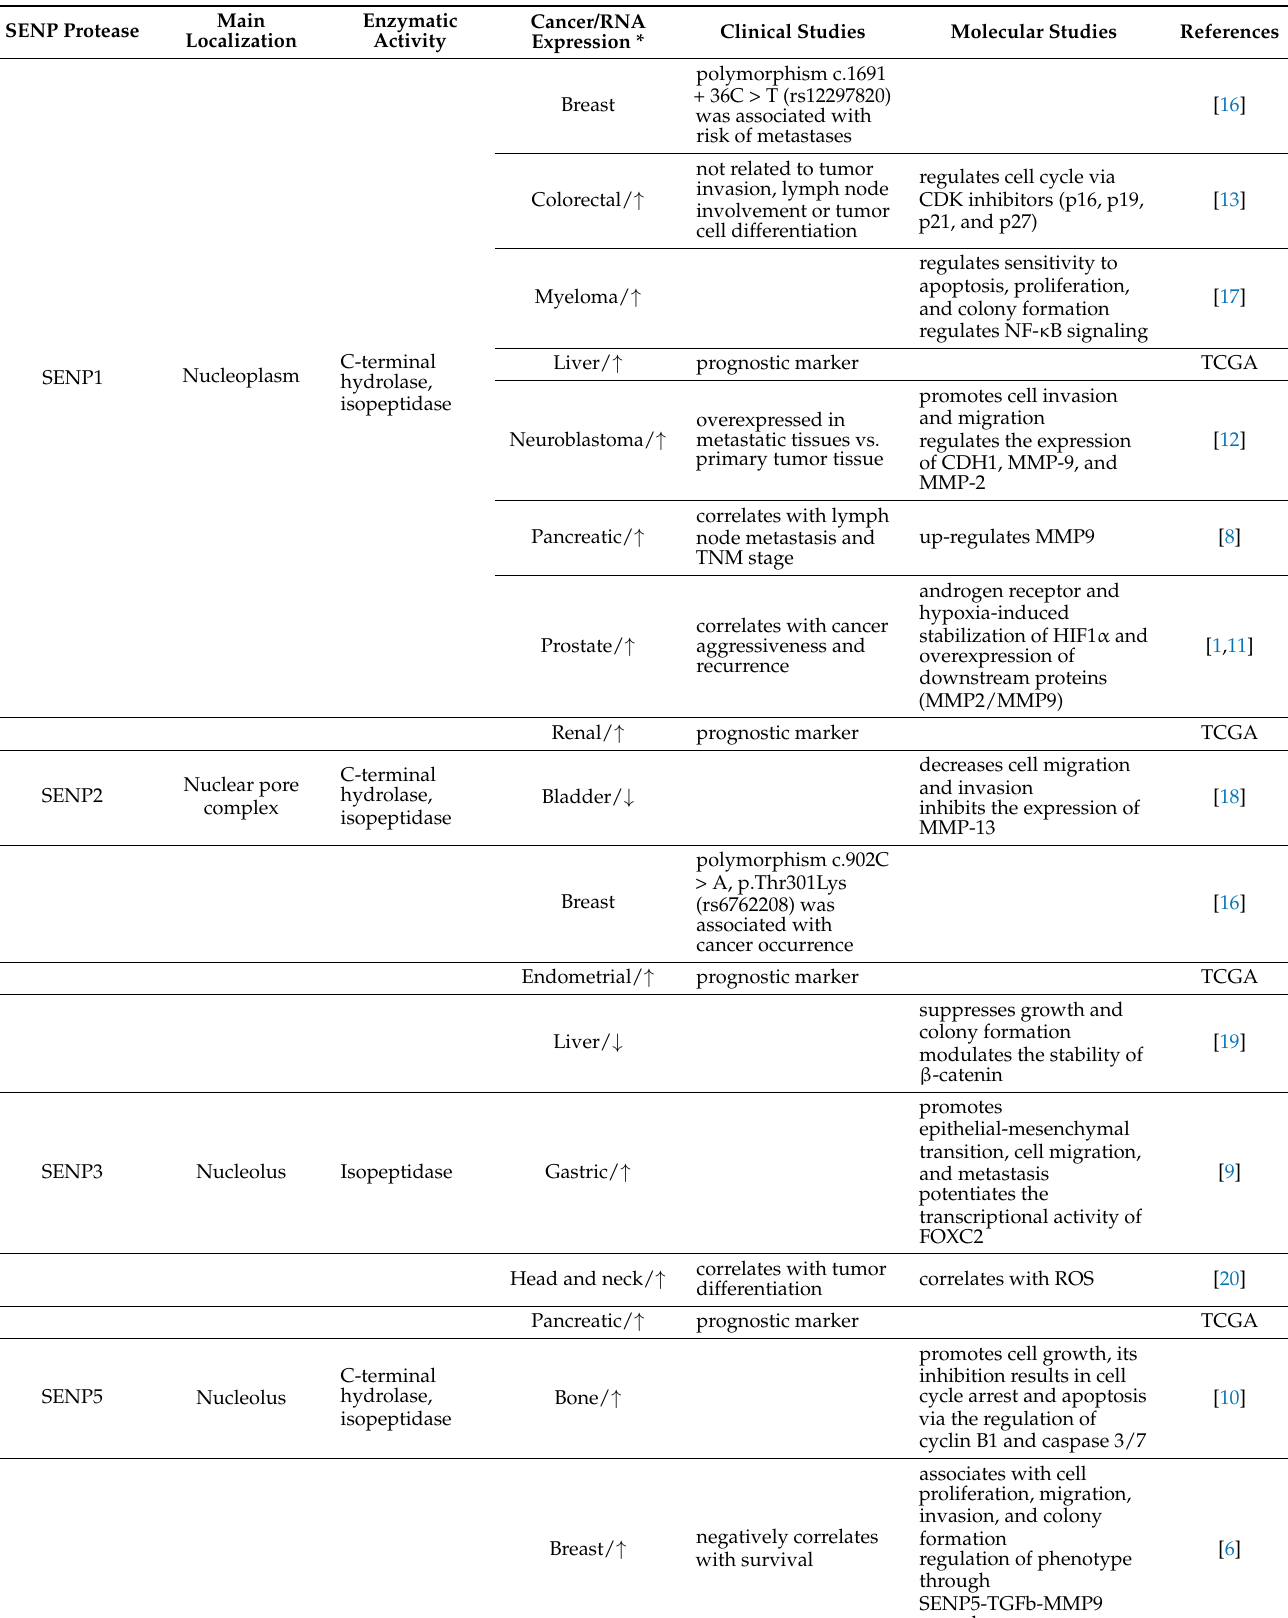
Table 1. SENP proteases in clinical and molecular